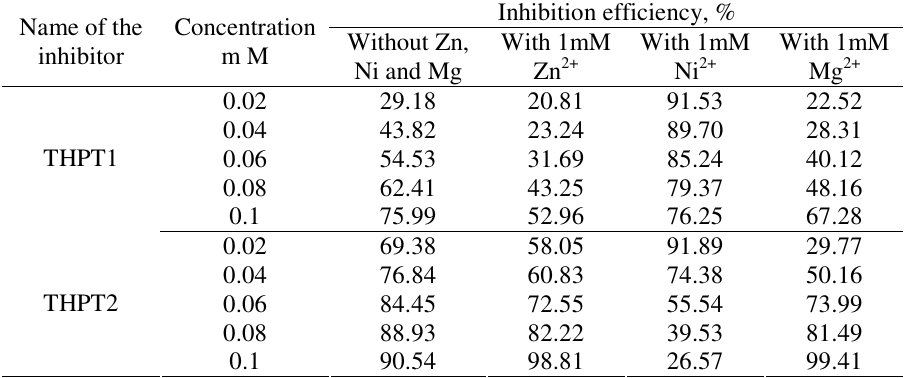
Table 9. Effect of metal ions on the inhibition efficiency of THPT1 and THPT2 by weight loss method at 30 ± 1 °